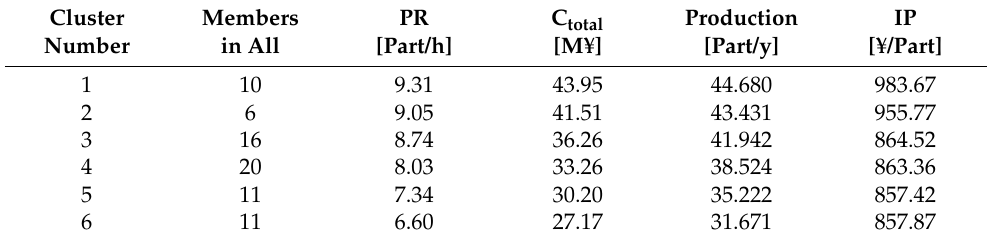
Table A9. Cluster analysis of the original approach [4] (Case C).